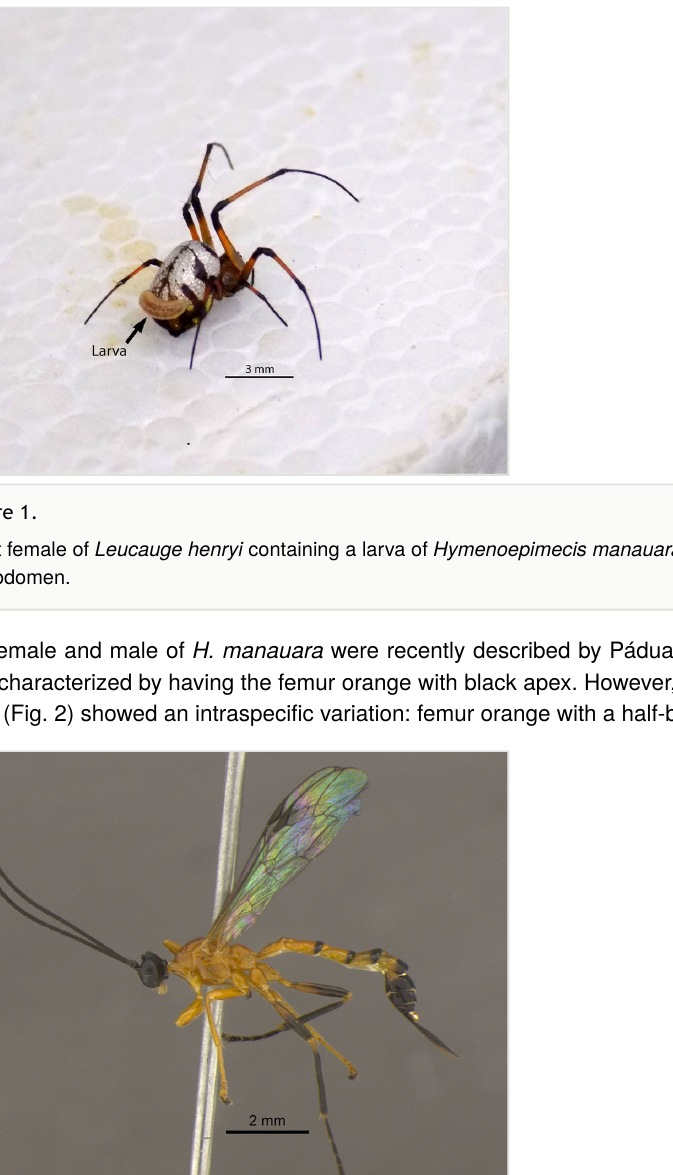
Figure 2. Adult female of Hymenoepimecis manauara